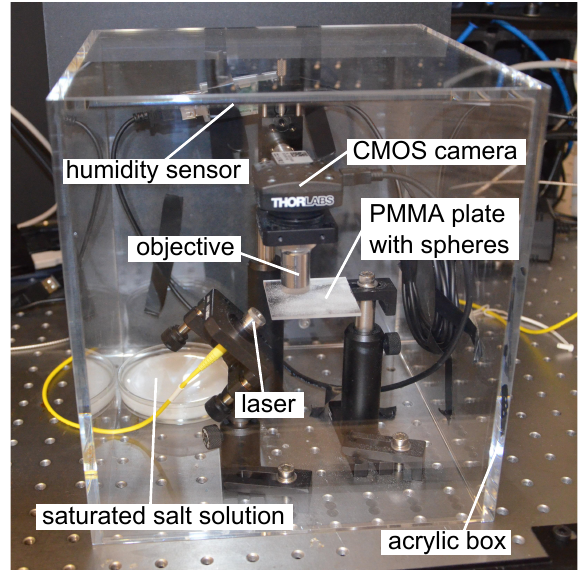
Figure 2. The WGM sensor, the commercially available relative humidity sensor and the saturated salt solution for humidity adjustment, placed under an acrylic